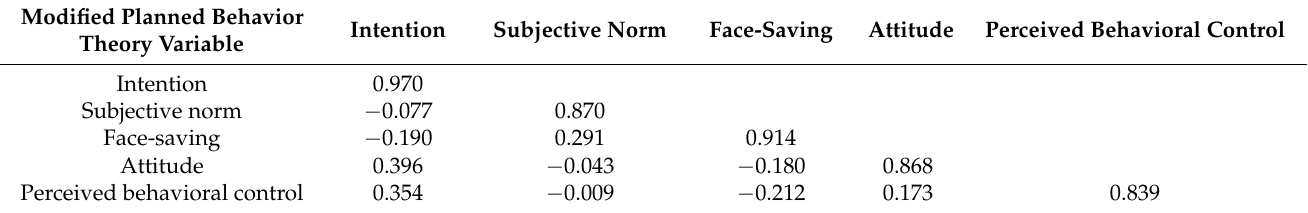
Table 4. Reliability and Validity of the Modified Theory of Planned Behavior Scale Using the Fornell–Larcker Criterion. Modified Planned